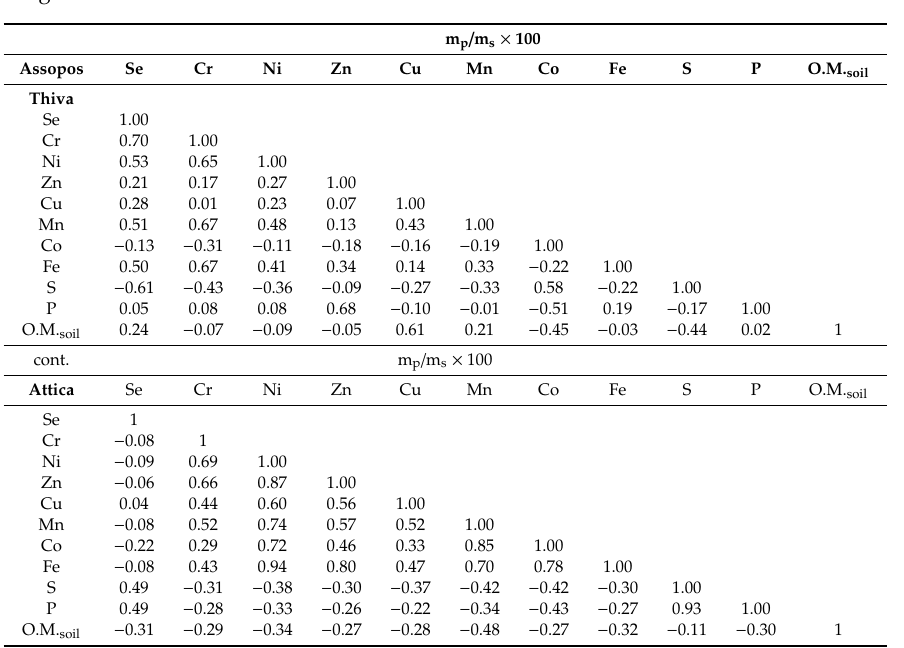
Table 4. Correlation matrix of percentage of soil elements in plants from Neogene Basins of Greece. Data from Tables 1 and 2. Symbols: m p —element content in plant; m s —element content in soil: O.M.—organic